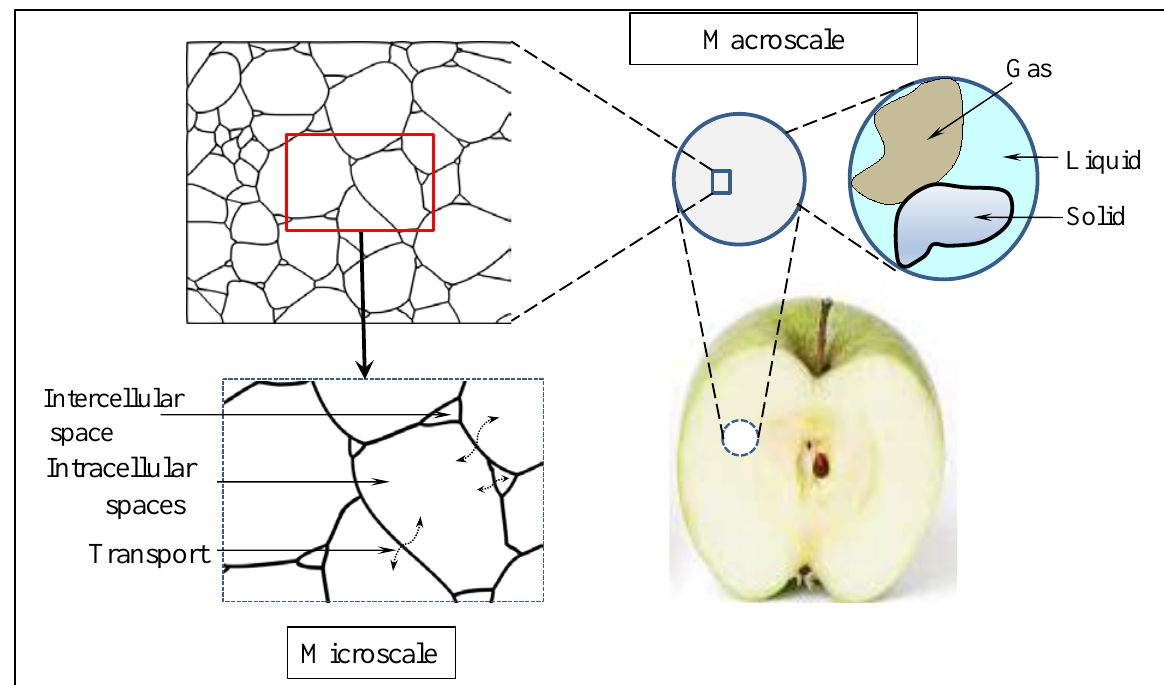
Figure 4. Schematic representation of microstructural elements of food materials.